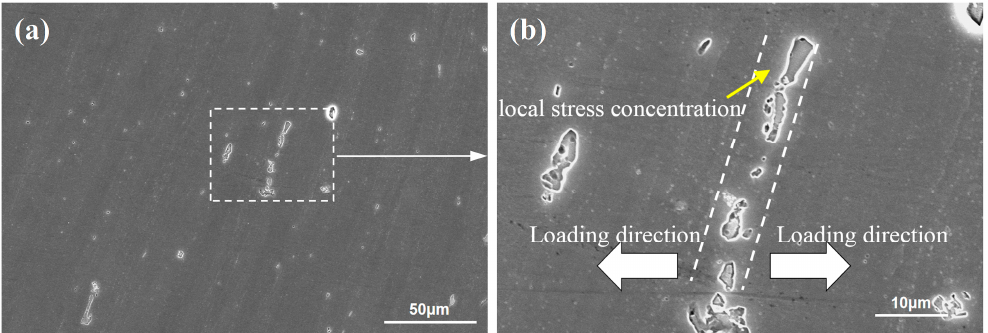
Figure 12. Distribution characteristics of second-phase particles at the FSW joint: ( a ) TMAZ; ( b ) enlargement of ( a ).